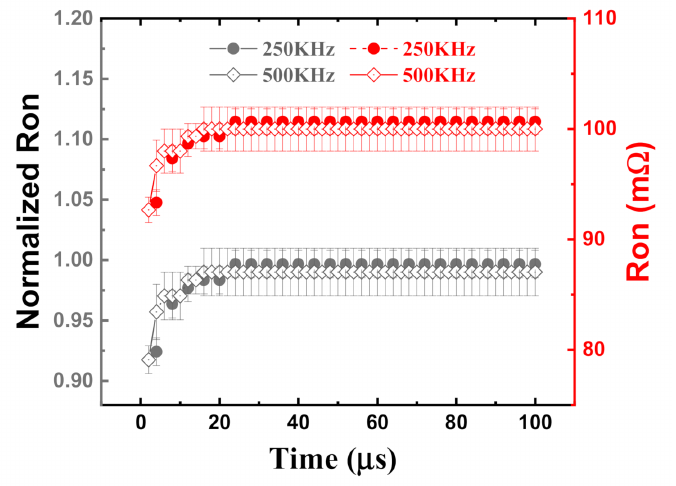
Figure 7. Normalized and measured dynamic R ON value at 1.96 µ s in every pulse under 250 kHz and 500